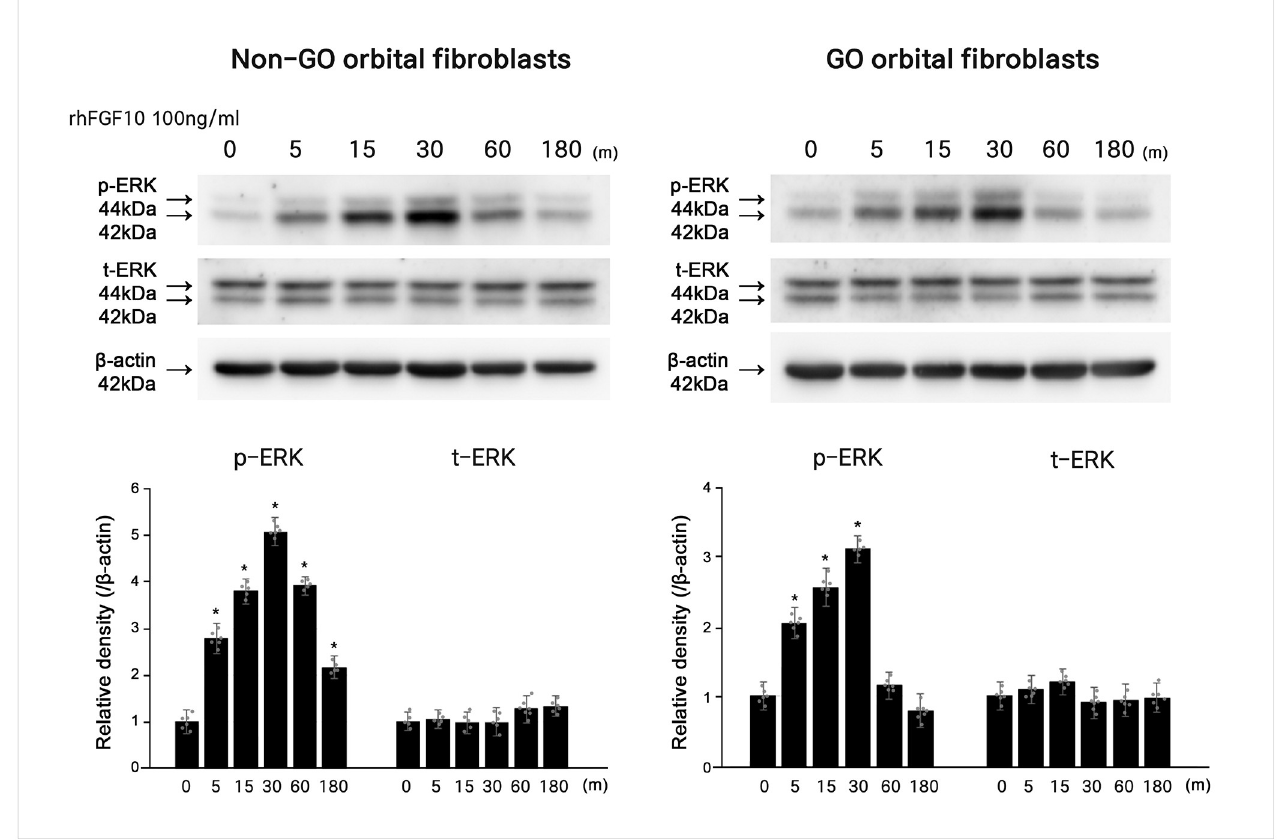
Fig 7. Role of fibroblast growth factor 10 (FGF10) in the phosphorylation of signaling molecule, extracellular signal-regulated kinase (ERK). The increase of phosphorylation of ERK was noted in rhFGF10 treated orbital fibroblasts from Graves 0 orbitopathy (GO) and non-GO patients. The phosphorylation of ERK gradually increased and decreased after peaking at 30 minutes of treatment. Bar graphs show the relative density of each protein normalized to the level of β - actin and are represented as mean ± standard deviation. Experiments were performed in at least three cells cultured from different strains. � p < 0.05.